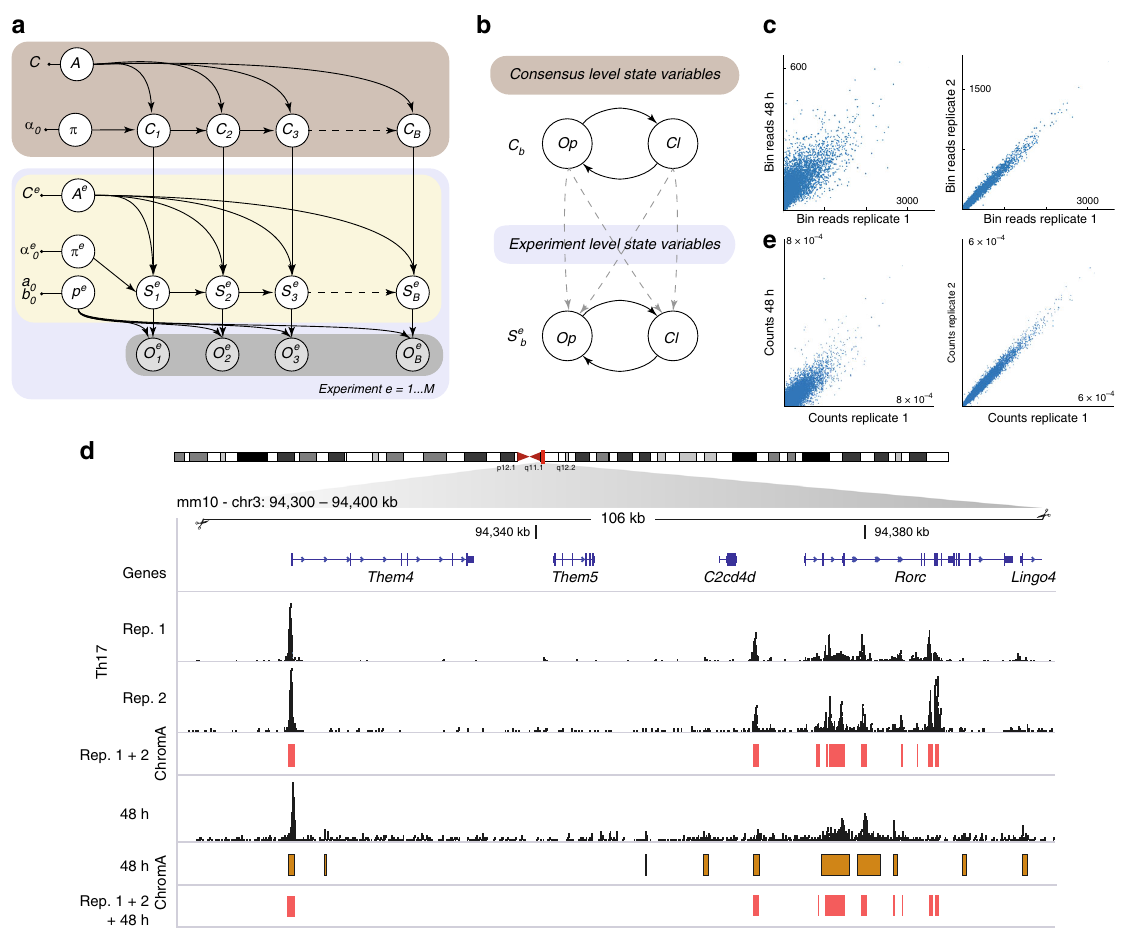
Fig. 5 Consensus ChromA integrates information from different data sets and replicates. a Consensus ChromA probabilistic hierarchical graphical model. The model is divided into a top (light brown) and a bottom layer (light blue). The bottom layer shows ChromA ’ s probabilistic model for each data set analyzed (akin to Fig. 1b). The top layer schematic shows how consensus variables, C , are explicitly linked to latent-state variables for each replicate (or integrated experiment) according to Markovian dynamics. π , p g , and A variables are as in Fig. 1b. b Consensus and experiment variables C and S e evolve alternating between open, Op, and closed, Cl, states. The top and the bottom layers are linked by introducing into each experiment a dependency on the state of the consensus variable. c Raw read correlation between replicates of sorted Th17 cells ’ data sets (right) and Th17 cells against CD4 + cells incubated in Th17 differentiation media for 48h (left). d Consensus-ChromA annotations integrates information from different replicates creating and deleting accessible regions based on the context. Raw reads from sorted Th17 cells ’ replicates and sorted CD4 + cells at a genomic locus. ChromA annotations for single CD4 + data set. Consensus-ChromA annotations for Th17 replicates and Th17 replicates and CD4 + cells are shown in red. e Consensus ChromA creates a common representation of chromatin accessible regions. When both Th17 replicates are combined together with CD4 + cells, the resulting consensus representation maintains the high correlation observed only when both Th17 cells ’ replicates are used. CD4 + peaks are fi ltered, and only correlated peaks